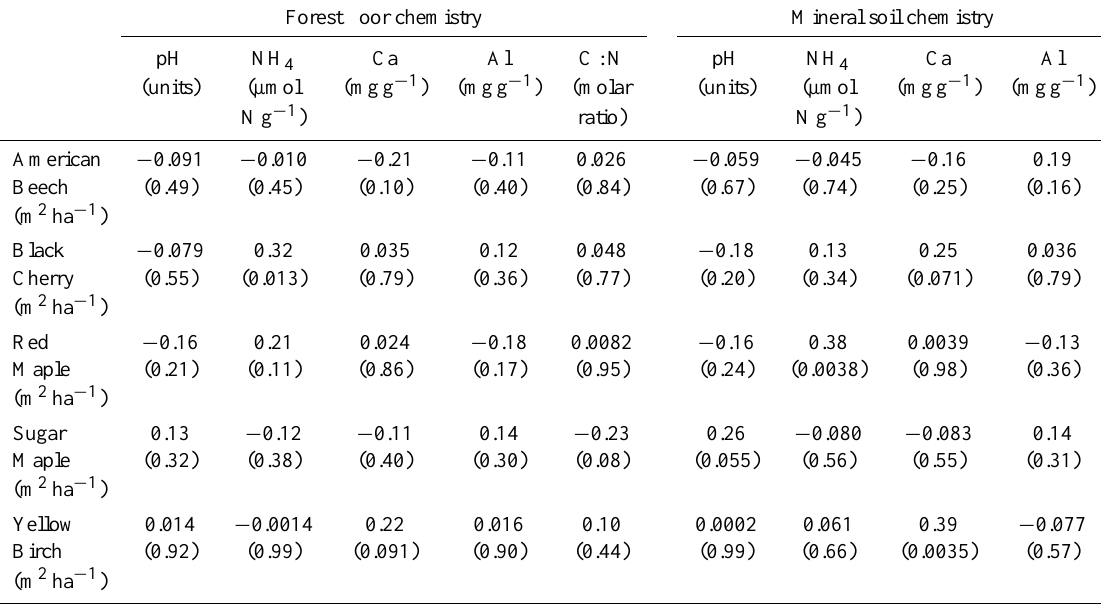
Table 3. Factor analysis. Forest floor data and tree species basal area Pearson correlation coefficients ( n =60) and mineral soil data and tree species basal area Pearson correlation coefficients ( n =55) with p